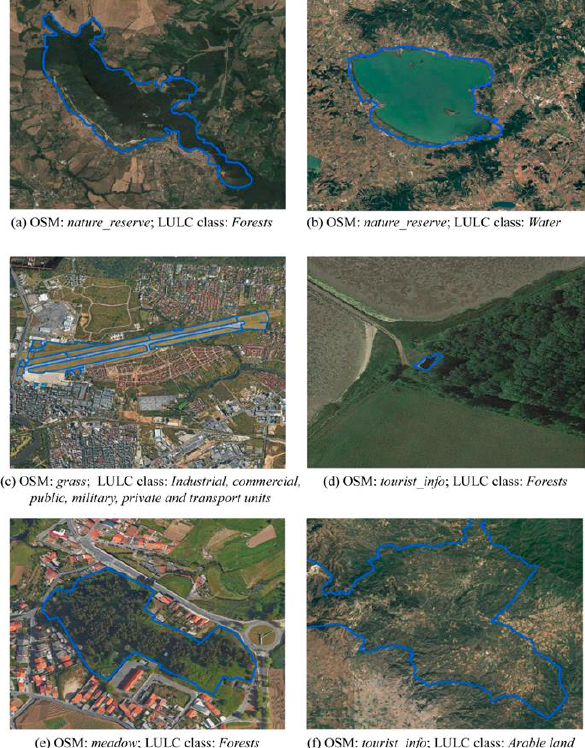
Figure 4 . Comparing some typical pairs of OSM tag and LULC class with corresponding images in Google Earth. Each OSM object was highlighted with a blue line